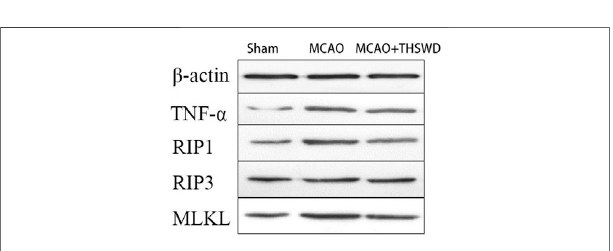
FIGURE 9 | β -actin is an internal reference. The blacker the band, the higher the protein expression level.